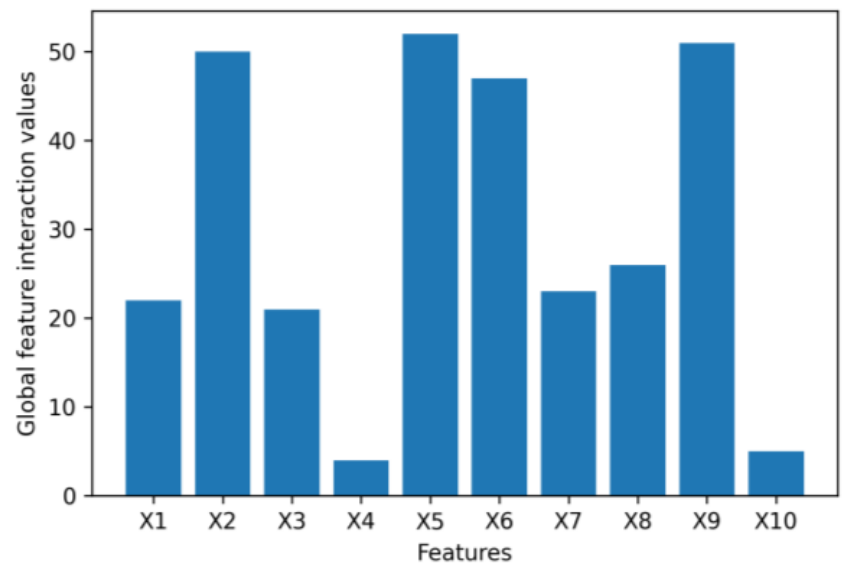
Figure 16. Global feature interaction values for dataset 1. Figure 17. Local feature interaction values for dataset 2. Figure 18. Global feature interaction values for dataset 2.